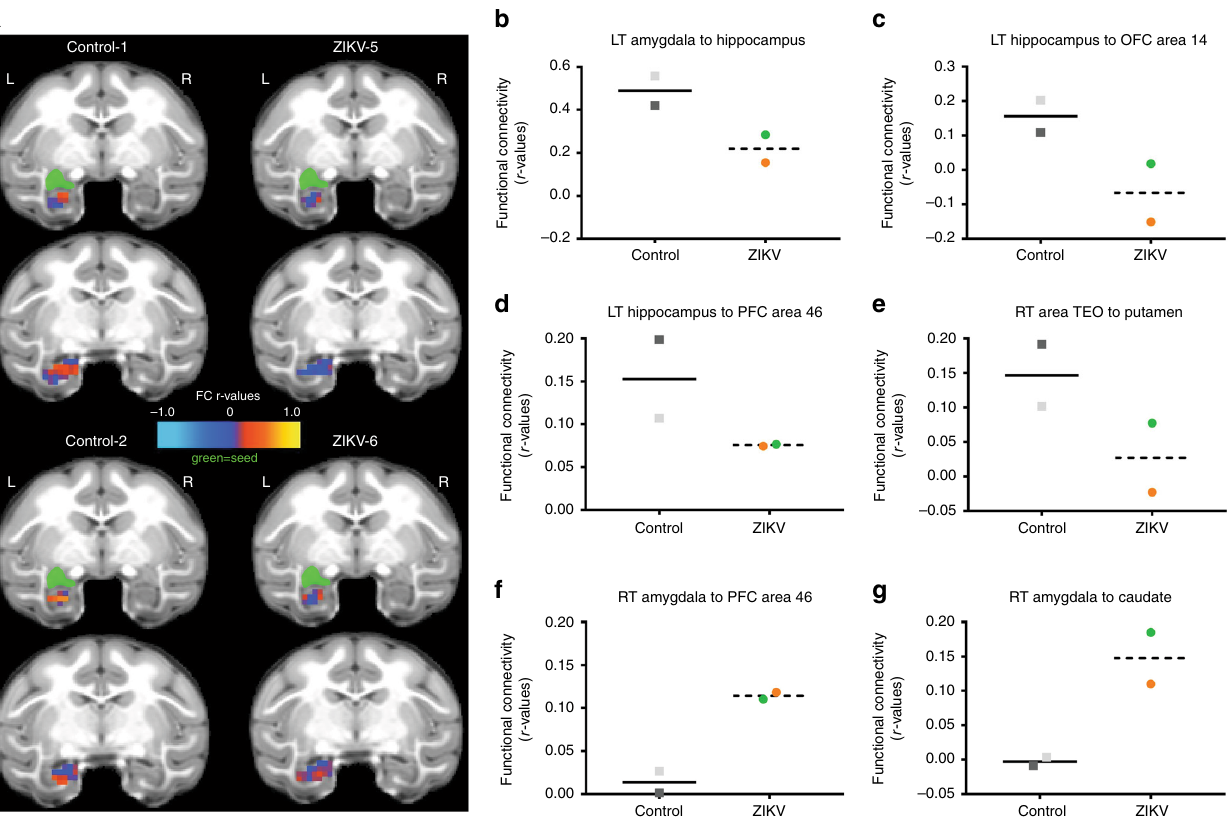
Fig. 4 Altered functional brain connectivity after postnatal ZIKV infection of infant RMs. a Depiction of amygdala – hippocampus resting state FC measured by rs-fMRI displayed on the UNC-Emory RM infant atlas 43 . Images show the same two coronal slice series in each subject, with the seed (green) placed in the left amygdala and the FC r values in the hippocampus colored according to the scale provided. L left hemisphere, R right hemisphere, r values, raw FC correlations. b – g Illustrate the rs-fMRI measurements of FC between speci fi c brain regions in ZIKV-infected infant RMs (dashed line with circles; green = ZIKV-5 and orange = ZIKV-6) and controls (solid line with squares; dark gray = Control-1 and light gray =